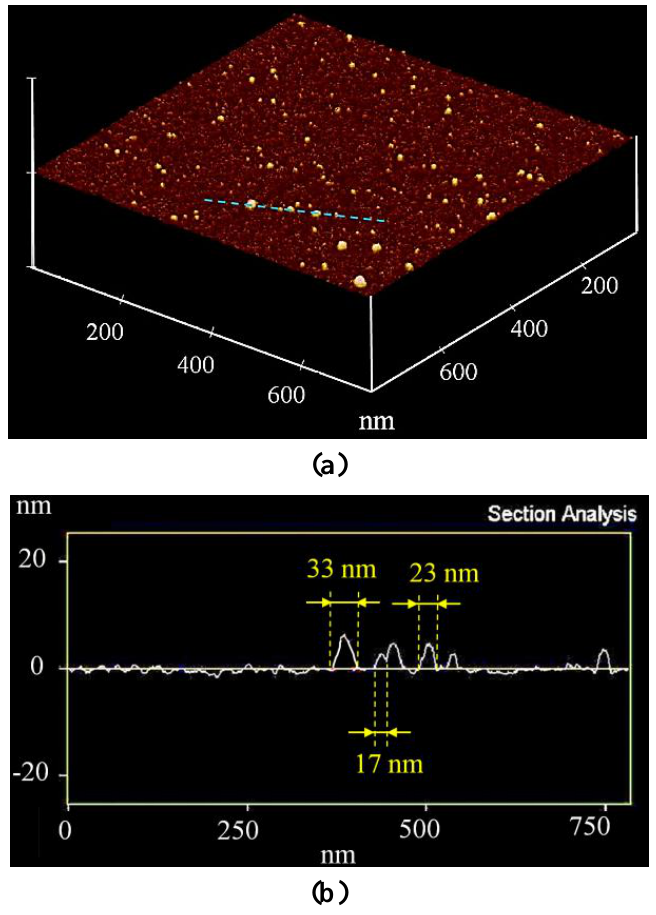
Figure 2. 3D atomic force microscopy (AFM) image of Ba surface ( a ); section analysis according to the blue line in the image ( b